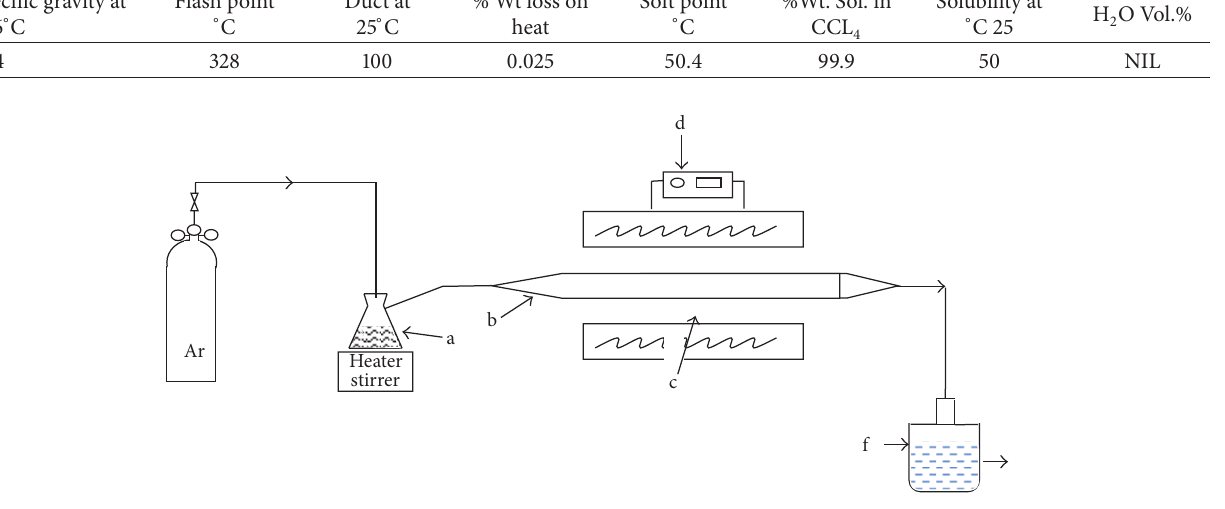
Figure 1: Experimental setup of CNS, CVD production rig. a: asphalt, b: quartz tube, c: tubular furnace, d: controller, e: catalyst boat, f: water trap.